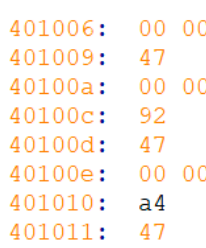
Figure 8. Deep learning–based malware-detection system. ASM: assembler source language.